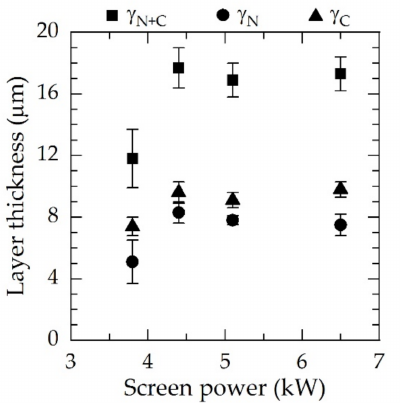
Figure 5. Layer thicknesses γ N and γ C and total layer thickness γ N + C as a function of the screen power for N 2 :H 2 = 1:1, T = 733 K, and t = 5 h measured on cross-sections.